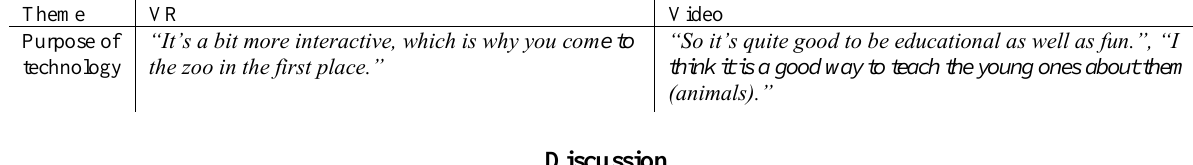
Examples of the Theme ‘Purpose of the Technology’ in the 19+ Age Group